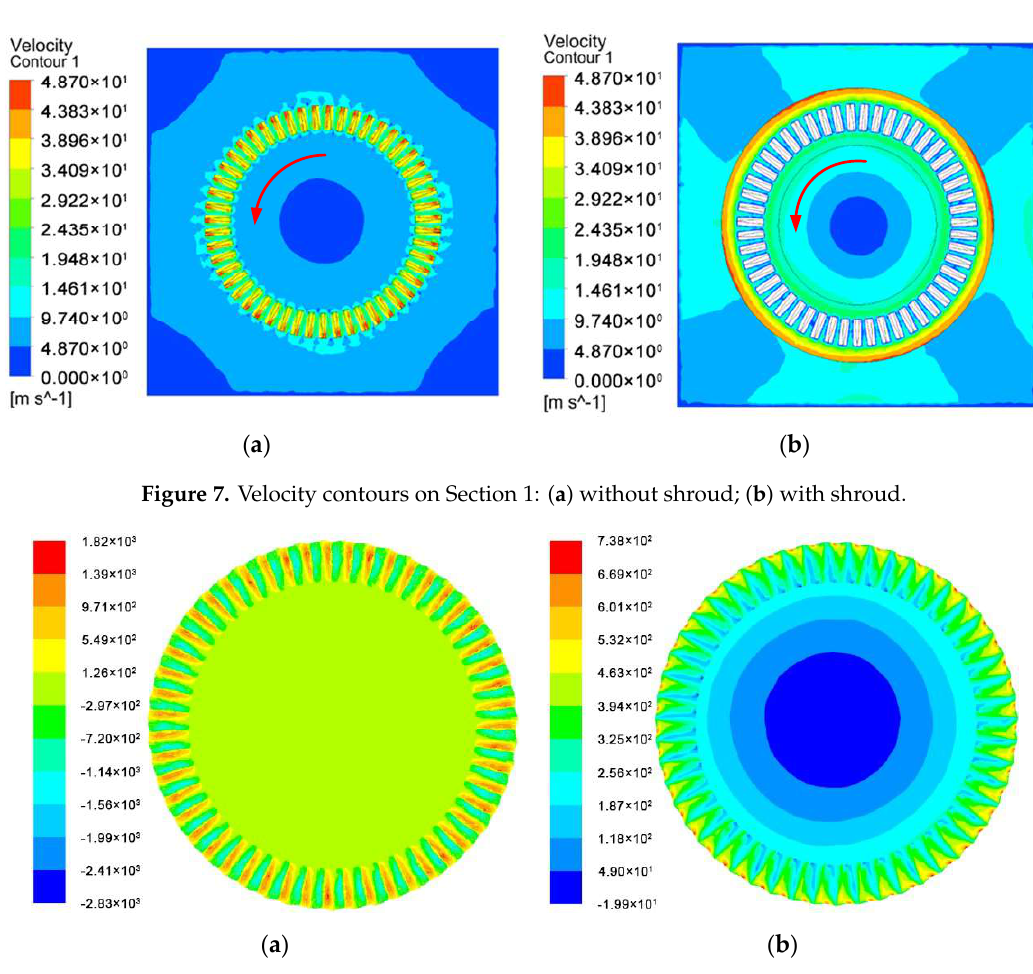
Figure 8. Pressure contours of the single face gear: ( a ) without shroud; ( b ) with shroud.